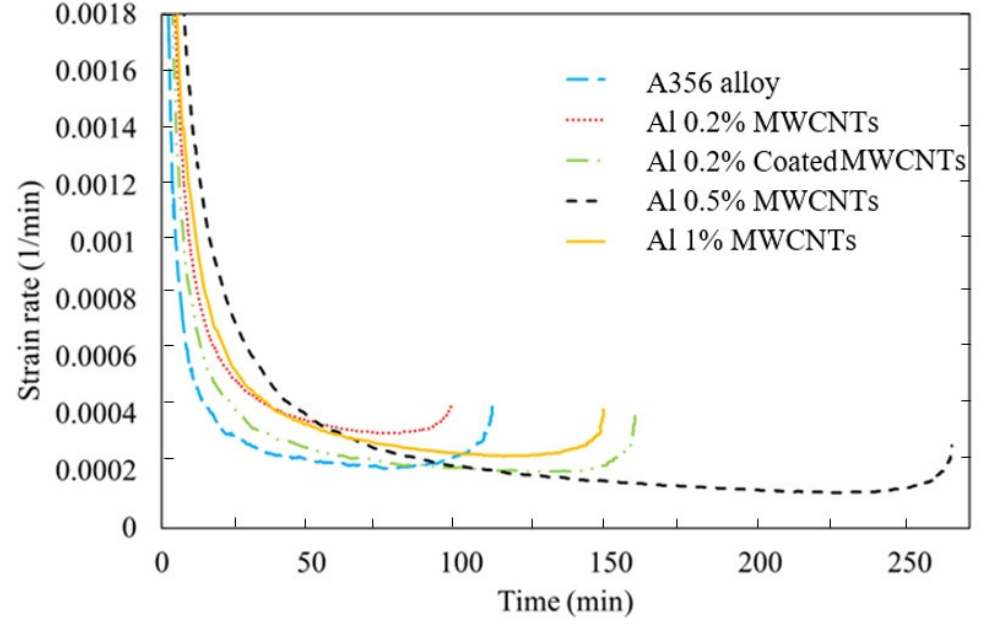
Figure 11. Creep strain rate–time diagram for A356 aluminum alloy and nanocomposites made with